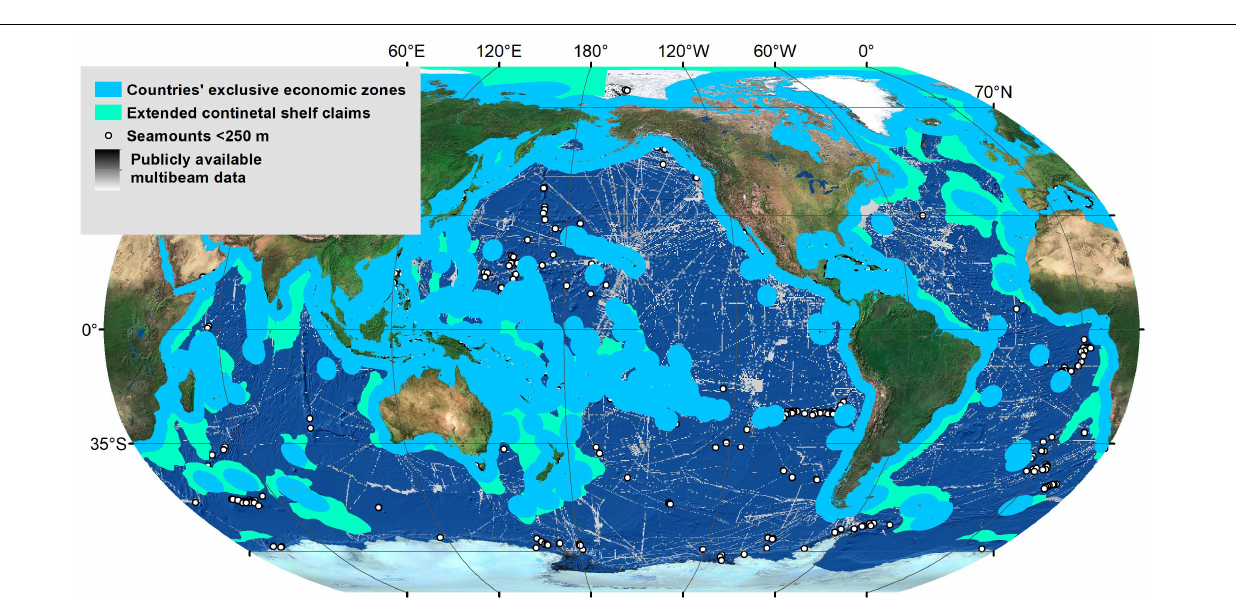
FIGURE 5 | Spatial distribution of seamounts that are predicted to have summits shallower than 250 m in depth based on modeled data in Yesson et al. (2011). These seamounts are likely to host high seas coral reefs and should be prioritized for future scientific explorations and conservation. However, many of these seamounts have not yet been mapped with modern echosounders, and therefore will need to be mapped in detail first in order to ground truth seamount depth data. Publicly available multibeam data from NOAA’s National Centers of Environmental